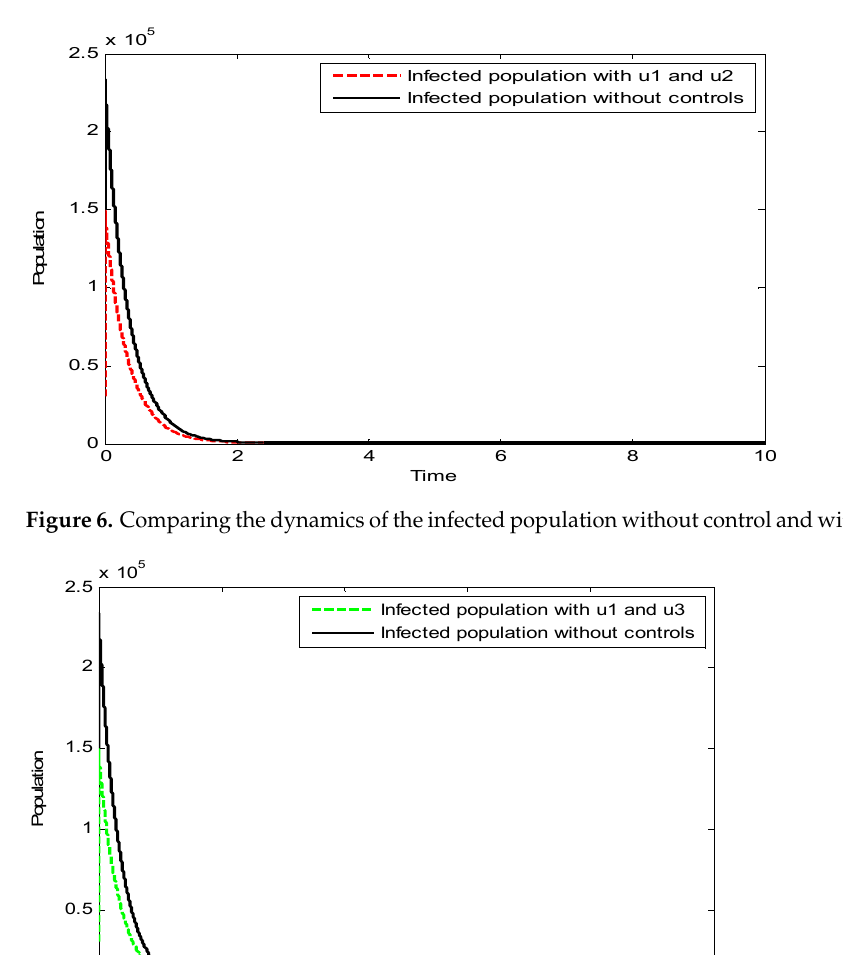
Figure 5. Comparing the dynamics of the infected population without control and with control u 3 .